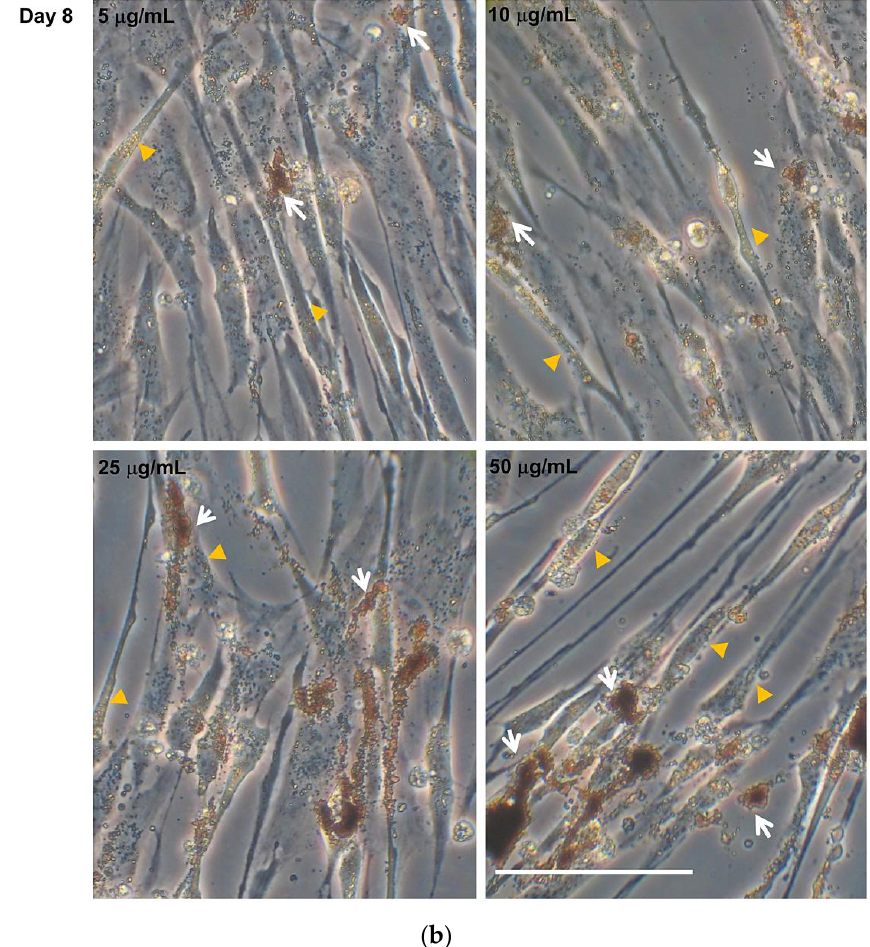
Figure 3. Morphological analysis of hNLCs cultured with Fe 3 O 4 NPs. Representative micrographs, by phase-contrast microscopy, of hNLCs after 3 ( a ) and 8 ( b ) days of culture in neurogenic medium with increasing Fe 3 O 4 NPs concentrations (5–50 µ g / mL). No morphological changes were induced by Fe 3 O 4 NPs exposure in hNLCs at day 3 and 8 of transdifferentiation. However, a cell density decrease was observed from 25 µ g / mL Fe 3 O 4 NPs at both time points considered. Brownish aggregates/agglomerates of Fe 3 O 4 NPs were observed in culture medium and intracellularly. White arrows indicate Fe 3 O 4 NP aggregates/agglomerates, orange heads indicate intracellular nanoparticles. Scale bar: 100 m.